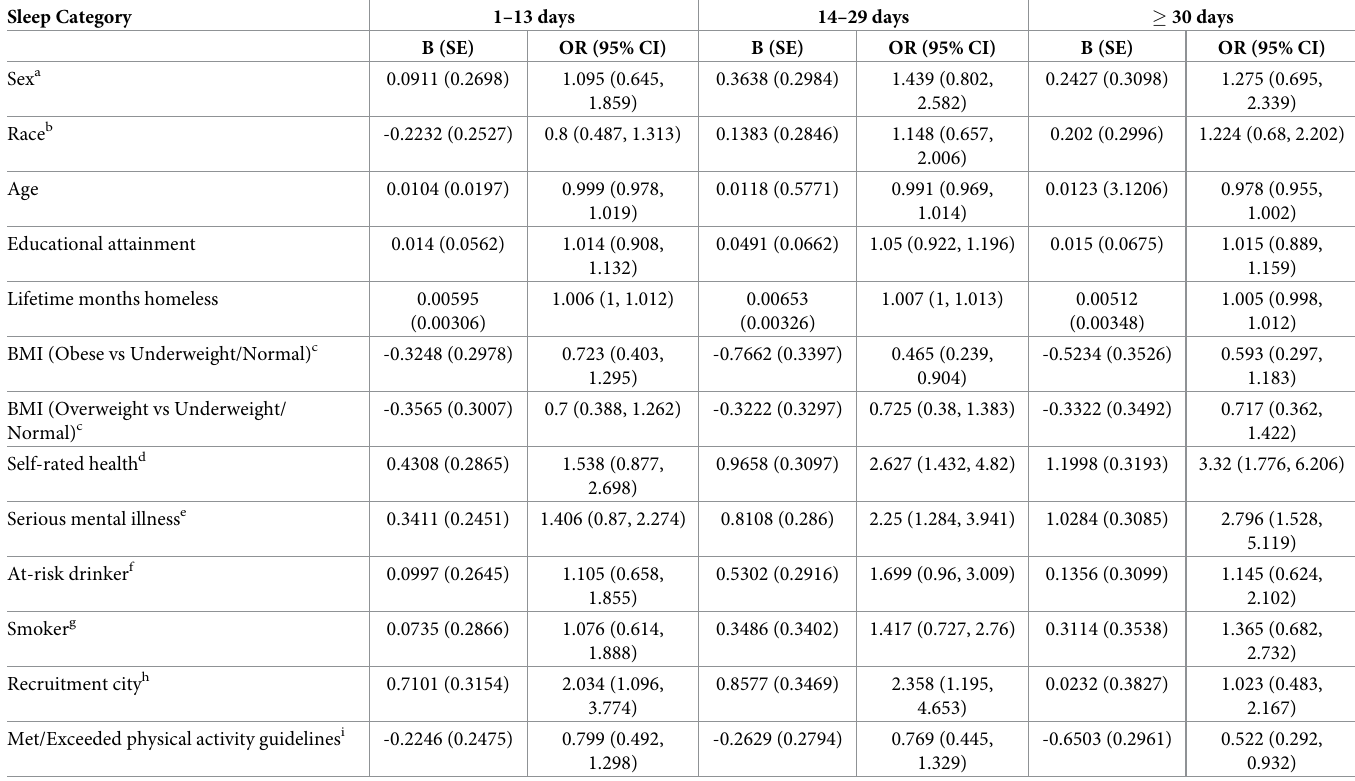
Table 3. Relation between days of insufficient rest/sleep and meeting/exceeding physical activity guidelines (N = 747). Sleep